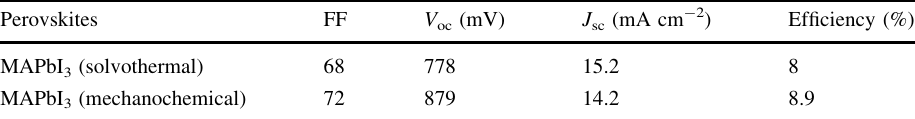
Table 3 Summary of the efficiency of cells synthesized in two different methods